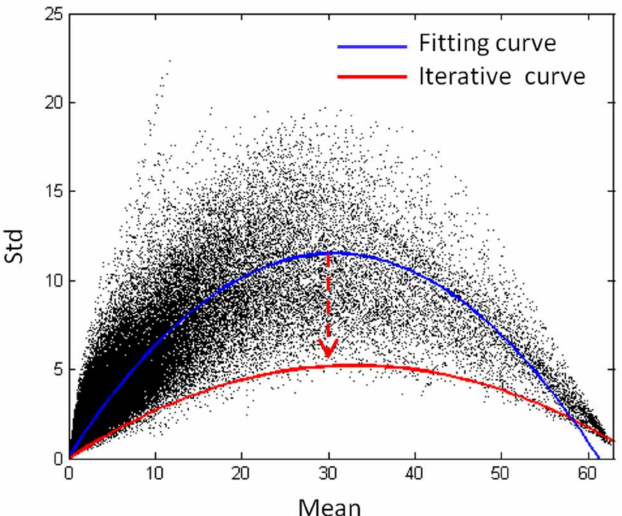
Figure 4. Scatter plot of mean and standard deviation of time series NTL images, where the dost denote the time series NTL pixel vector P i , the fitting curve is fitted by all the pixels, and the iterative cure is calculated by the method described above. It takes three iterations to reach the final state. The dots, which are under the iterative curve, are selected as the invariant pixels.